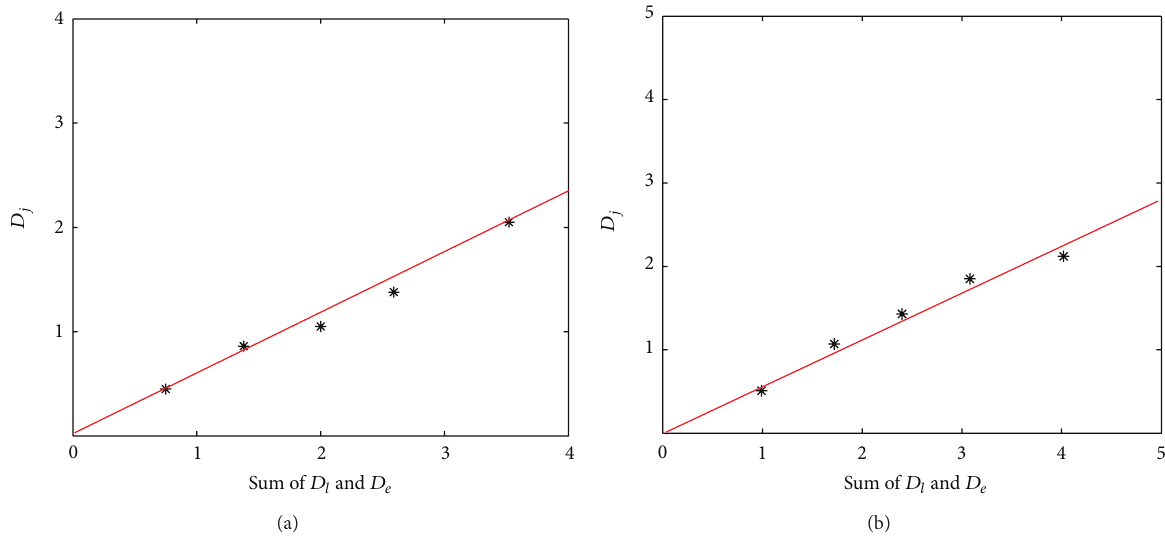
Figure 10: Relationship between the 𝐷 𝑗 and the sum of 𝐷 𝑙 and 𝐷 𝑒 under QP 20. (a) Error length is 4. (b) Error length is 8.